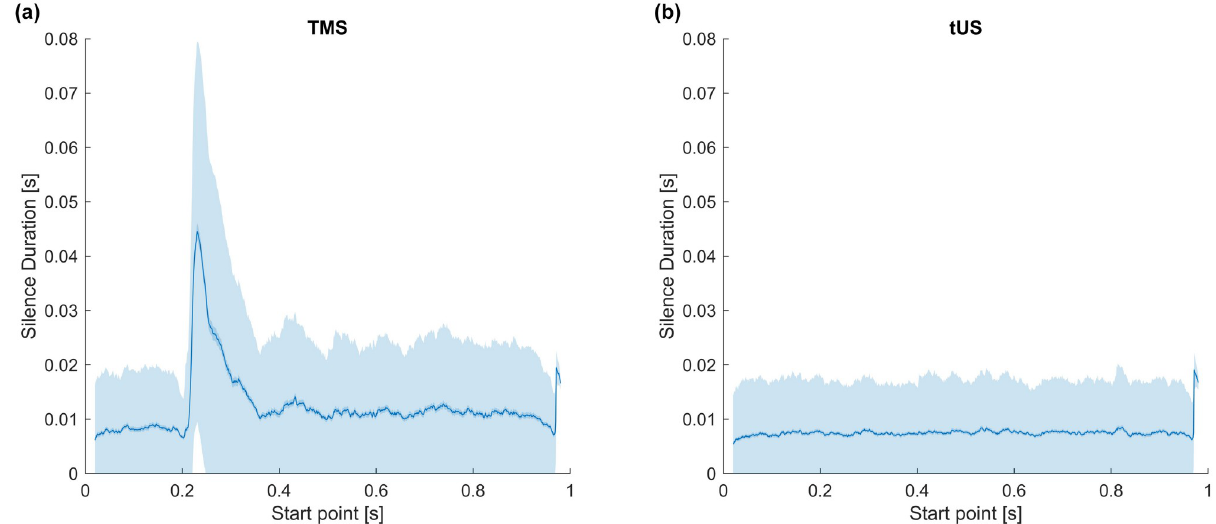
Fig 3. Silence durations across trials, using a sliding window. Duration is as measured from the start point of a given sliding window iteration. (a) TMS. (b) tUS. X-axis: Timepoint measured from. Middle Trace: Mean silence duration. Inner Margin: SEM. Outer Margin: STD.